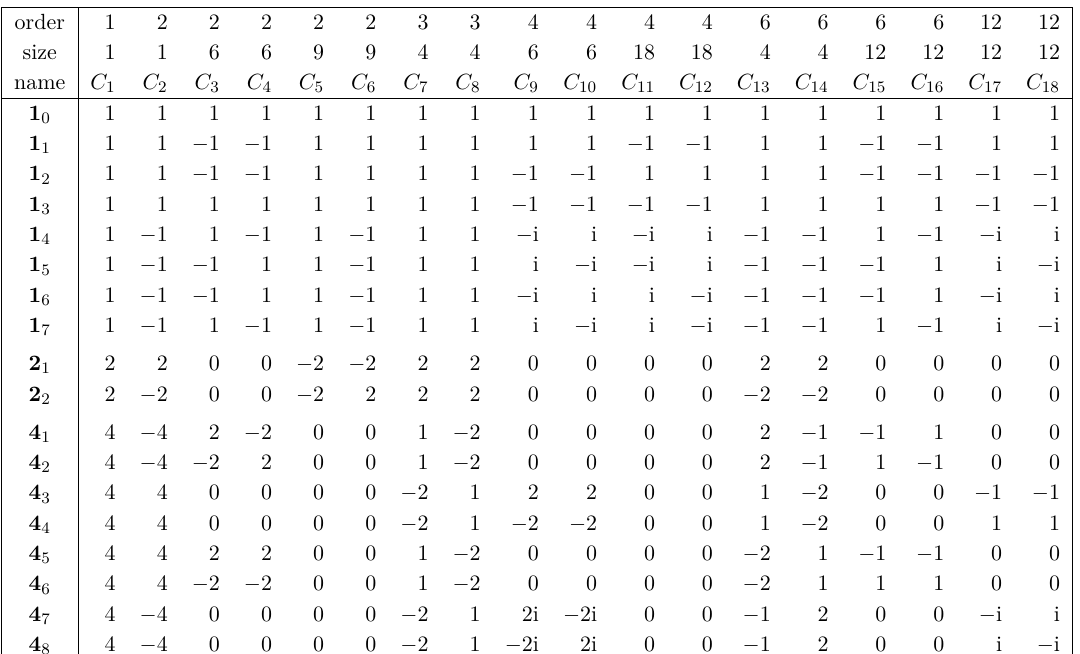
Table 4. Character table of ( S T elements in a conjugacy class and ‘order’ denotes the order of its